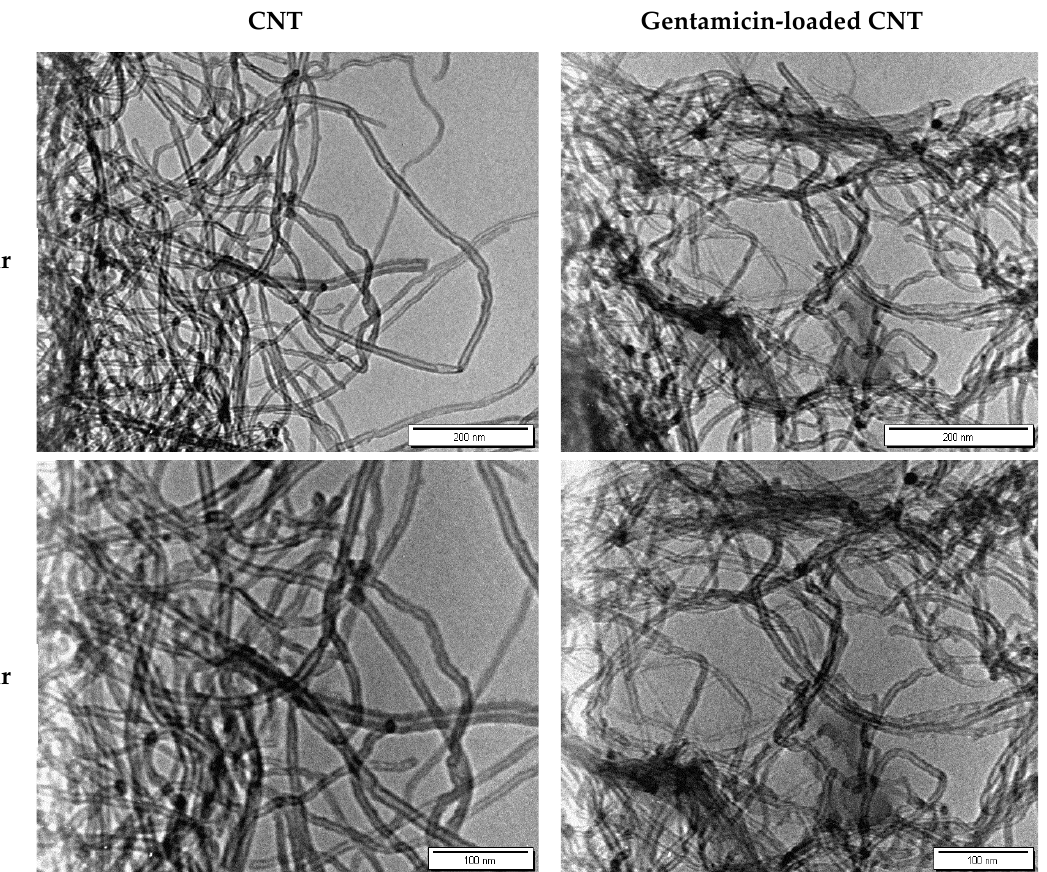
Figure 1. TEM images for CNTs (left) and gentamicin-loaded CNTs (right).